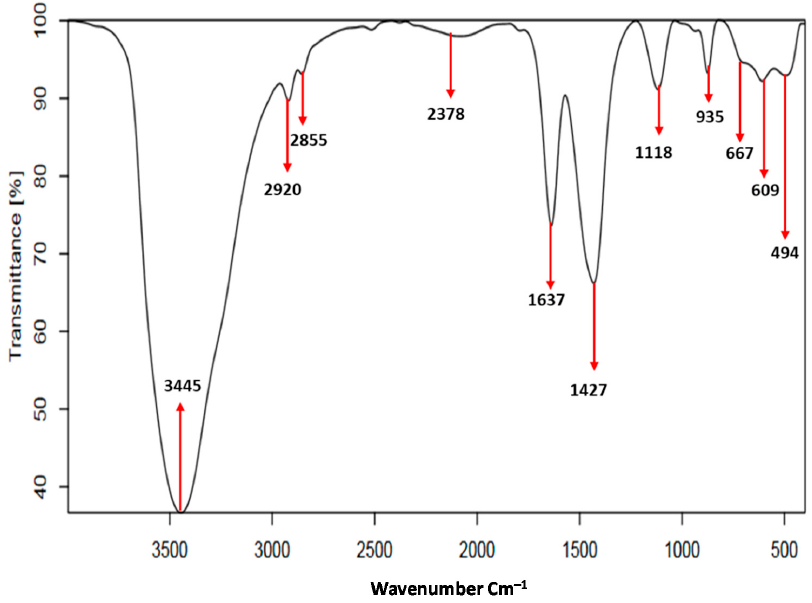
/ CTAB-EC composite used in CV Figure 3. FTIR spectrum of MNP/CTAB-EC composite used in CV adsorption. Figure 3. FTIR spectrum of MNP Figure 3. FTIR spectrum of MNP/CTAB-EC composite used in CV adsorption.